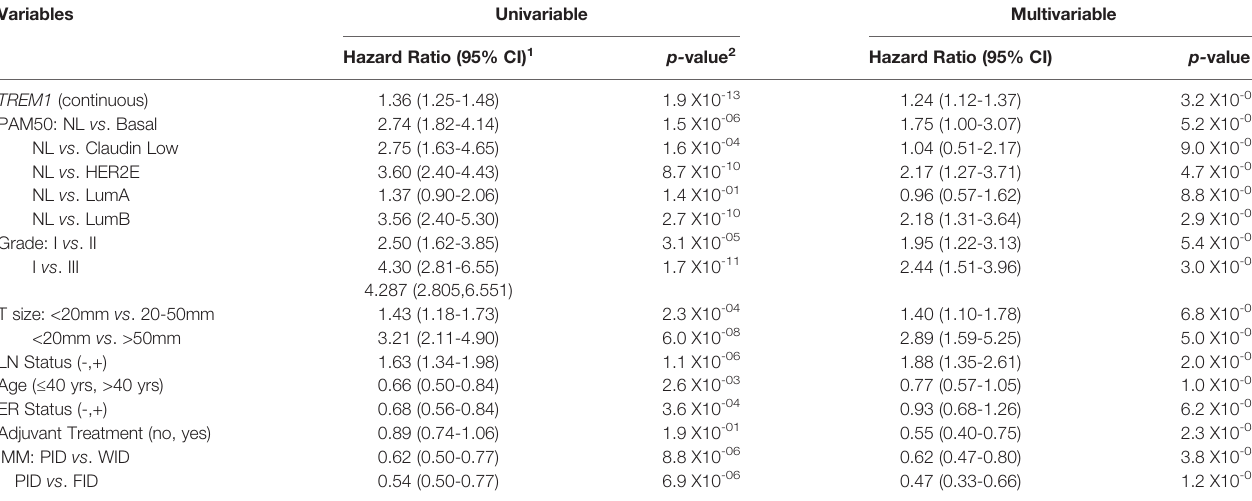
TABLE 2 | Cox proportional hazards regression analysis for associations with distant metastasis-free